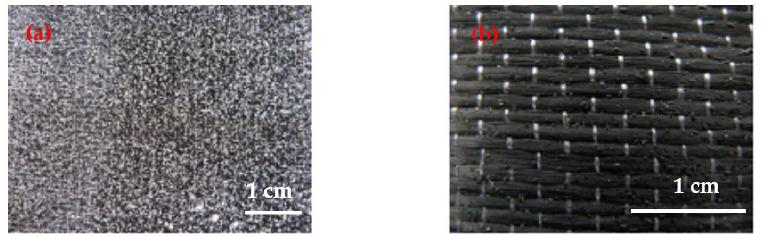
Figure 1. Images of carbon fiber fabric surfaces with benzoxazine-based tackifier BT5501A, ( a ) before baking and ( b ) after baking.